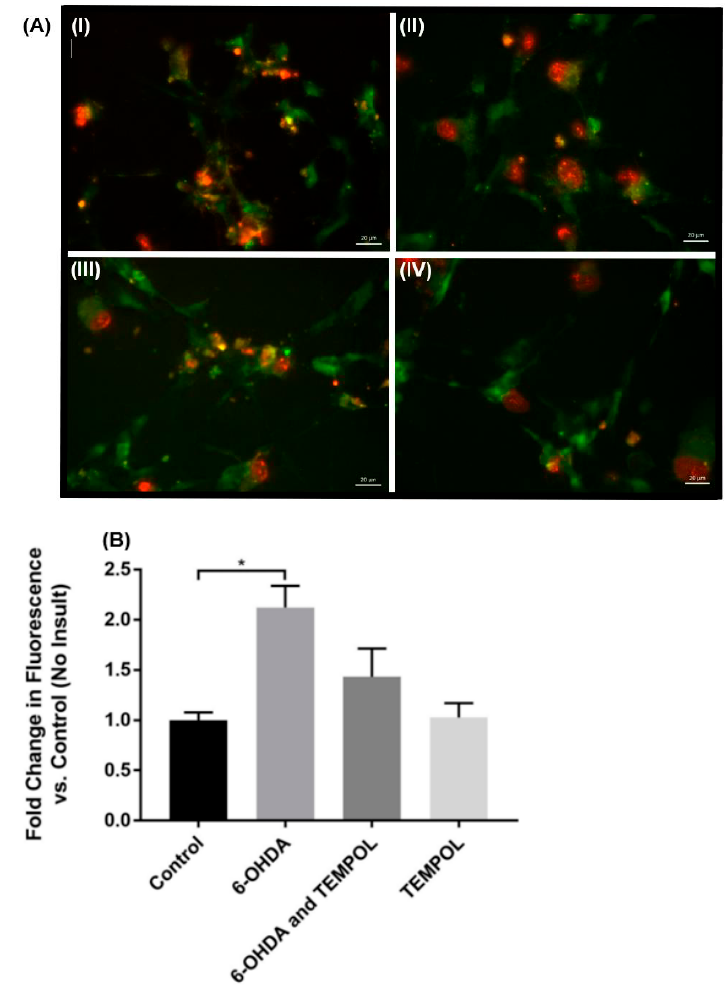
Figure 4. Assessment of mitochondrial superoxide anion radical production in cultured SH-SY5Y cells after treatment with 6-OHDA ± TEMPOL. Mitochondrial superoxide anion free radical production was investigated using the selective fluorescent dye, MitoSOX Red. Panel ( A ) Fluorescent microscopy panels showing cellular response after 24 h culture with (I) Vehicle (control) dopaminergic cells, (II) 30 μ M 6-OHDA, (III) 30 μ M 6-OHDA + 30 μ M TEMPOL or (IV) 30 μ M TEMPOL alone followed by subsequent incubation with MitoSOX Red and finally counterstaining with MitoTracker Green FM. Images are representative of n = 3 (each performed in triplicate) captured at 40X. ( B ) Quantification of MitoSOX Red fluorescence levels. Data represents mean ± SEM, n = 7 independent experiments. Different to the vehicle treated control; * p ≤ 0.05. Cells co-treated with 6-OHDA + TEMPOL or TEMPOL alone were not different to the vehicle control.